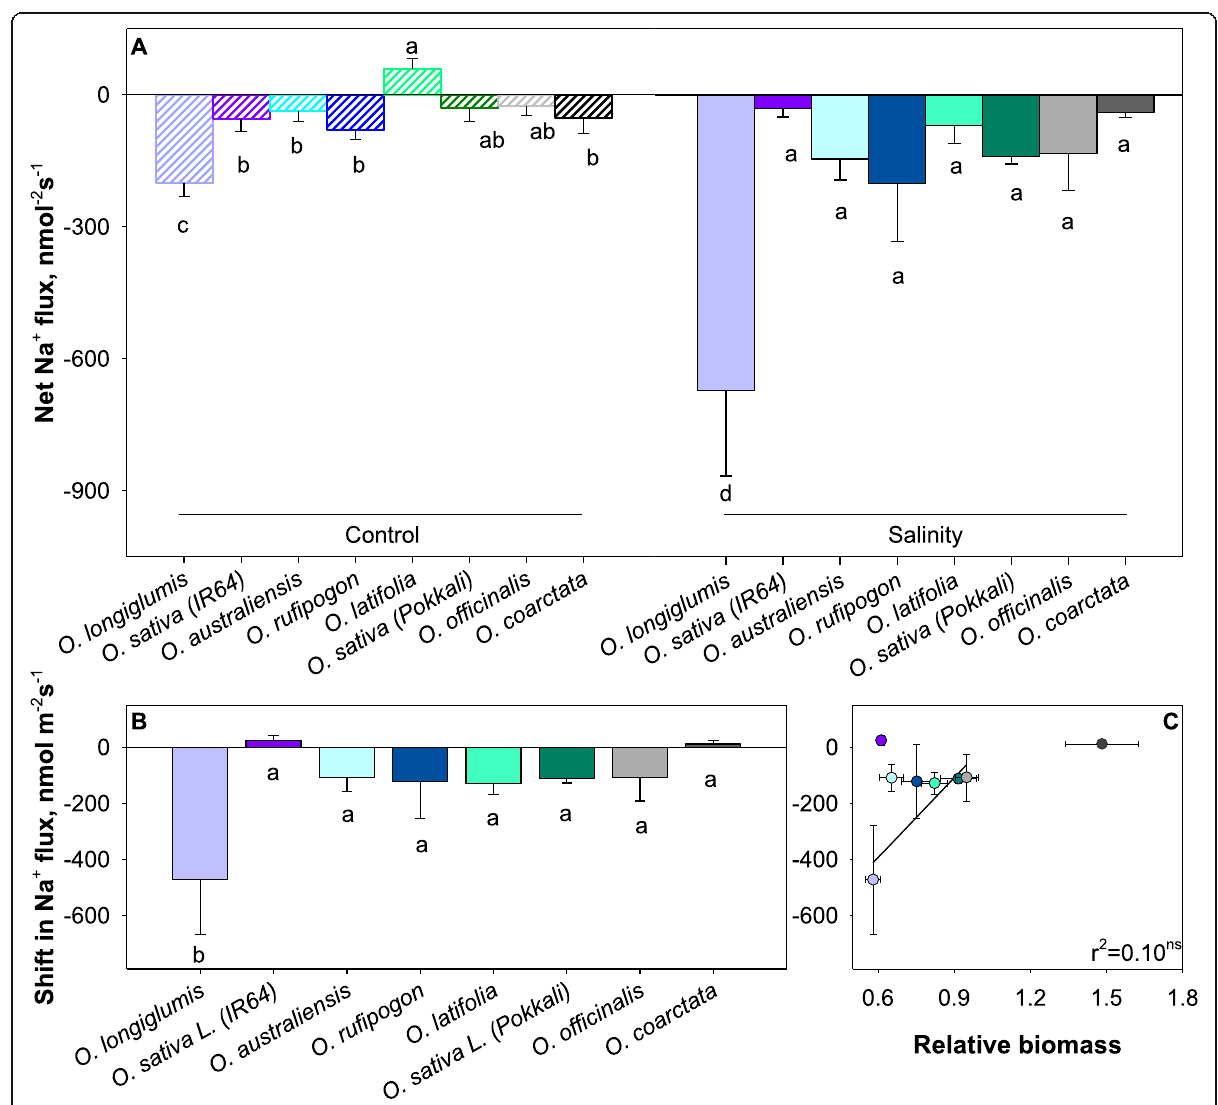
Fig. 3 Linking salinity tolerance of wild and cultivated rice to net Na + ion fluxes of mesophyll cells. Salinity treatment was applied at 100 mM NaCl for 42 days. ( A ). Shift in K + flux was the flux difference between flux from salinity stressed and control samples ( B ). Pearson analysis of shift in Na + flux with relative biomass ( C ). Data are mean values and the error bars indicate the standard errors. Different lowercase letters